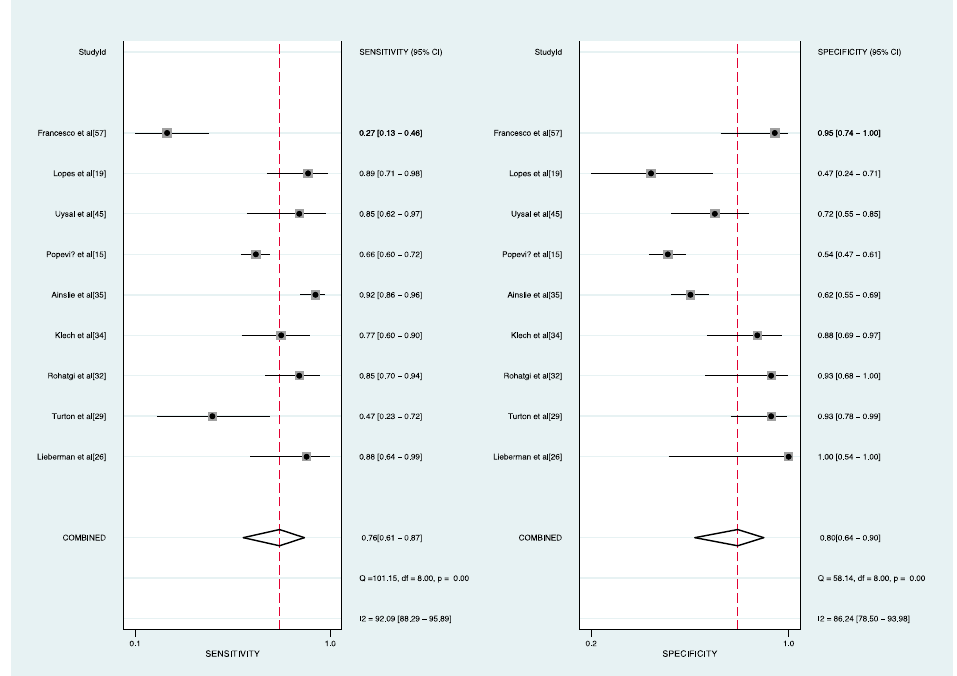
Figure 4. Forest plots of sensitivity and specificity of the sACE for diagnosing active sarcoidosis Left : sensitivity; right : specificity.